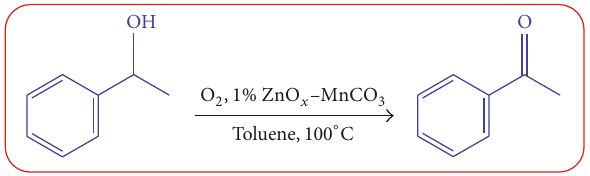
Scheme 2: Aerial oxidation of 1-phenylethanol into